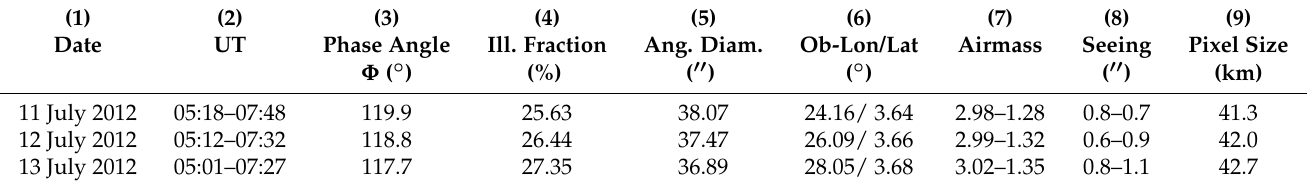
Table 1. Orbital geometry and circumstances of ground-based observations : (1–2) Date/UT interval; (3–5) disk aspect; (6) sub-observer longitude and latitude (planetocentric); (7–9) observing conditions and geometry. The image pixel scale in km (9) was computed at disk centre and using NICS camera resolution, at the TNG telescope, of 0.13 arcsec/pix.